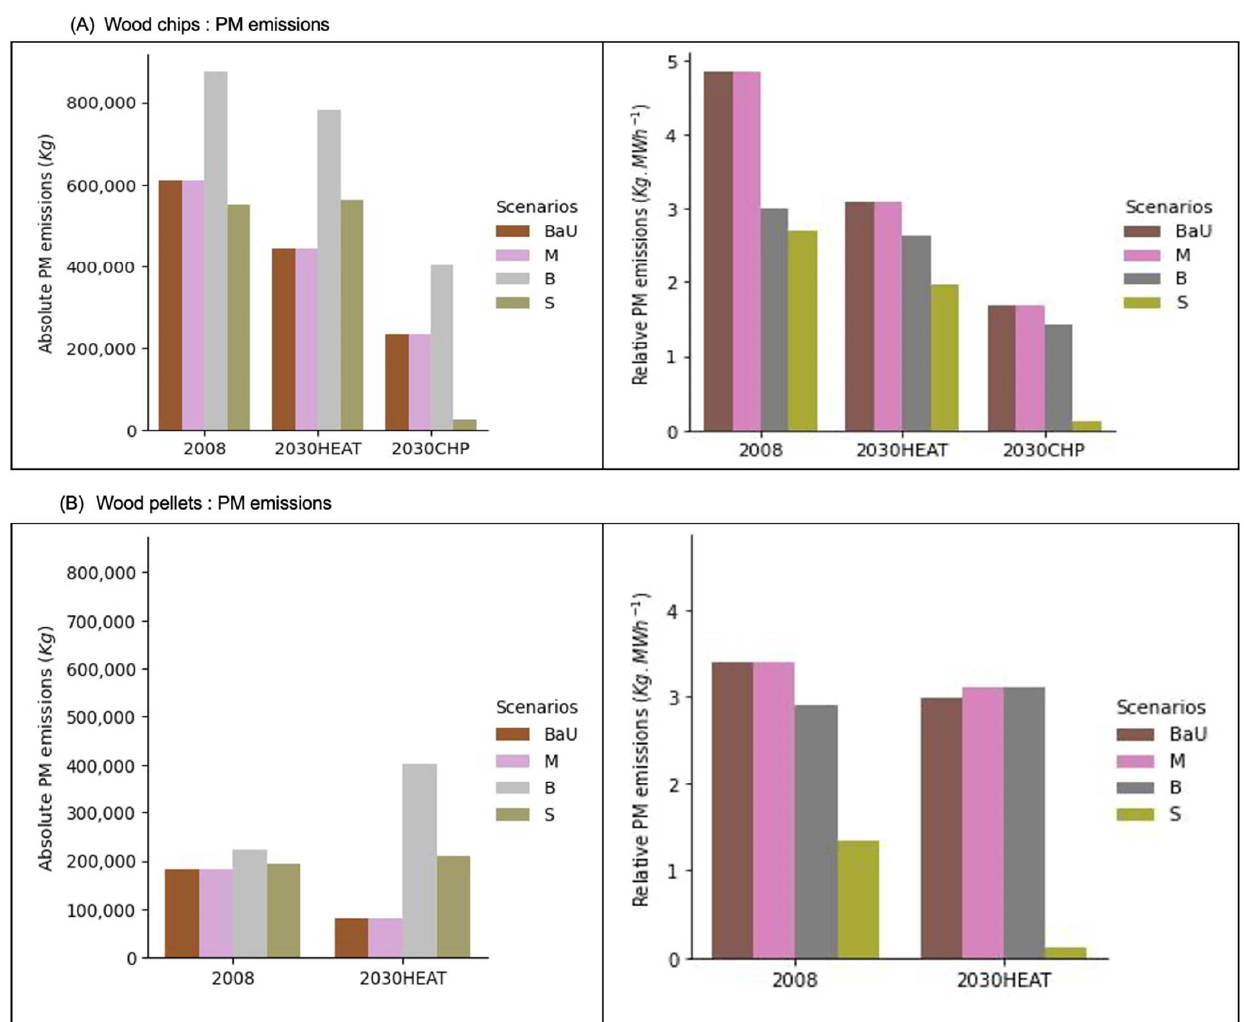
Figure 4. Particulate matter (PM) emissions for wood chip ( A ) and wood pellet ( B ) value chain scenarios. Left panel: absolute PM emissions, expressed in kg of PM emitted. Right panel: relative PM emissions, expressed in kg of PM emitted per kWh of energy produced.